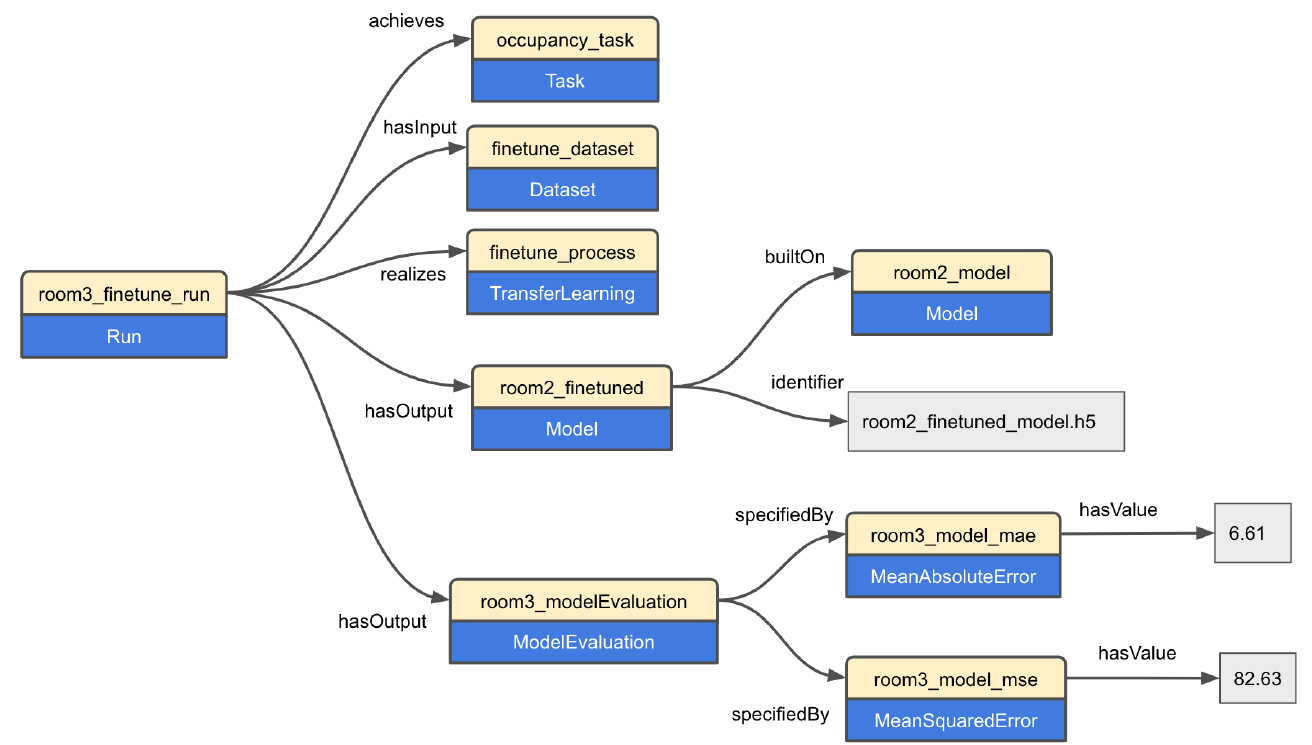
Figure 6. Part of the knowledge graph describing a fine-tuned